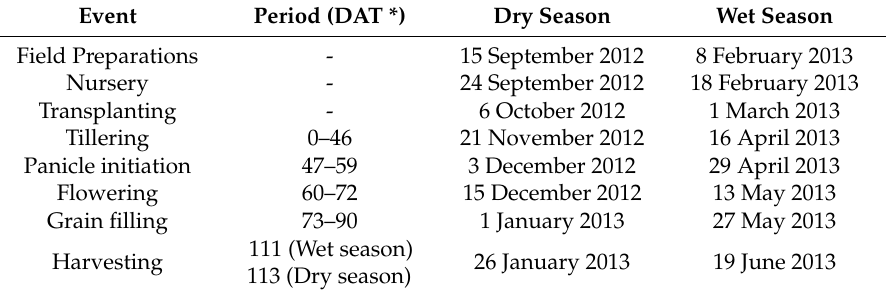
Table 1. Crop management and development stages for dry and wet seasons. Event Period (DAT *) Field Preparations - Nursery